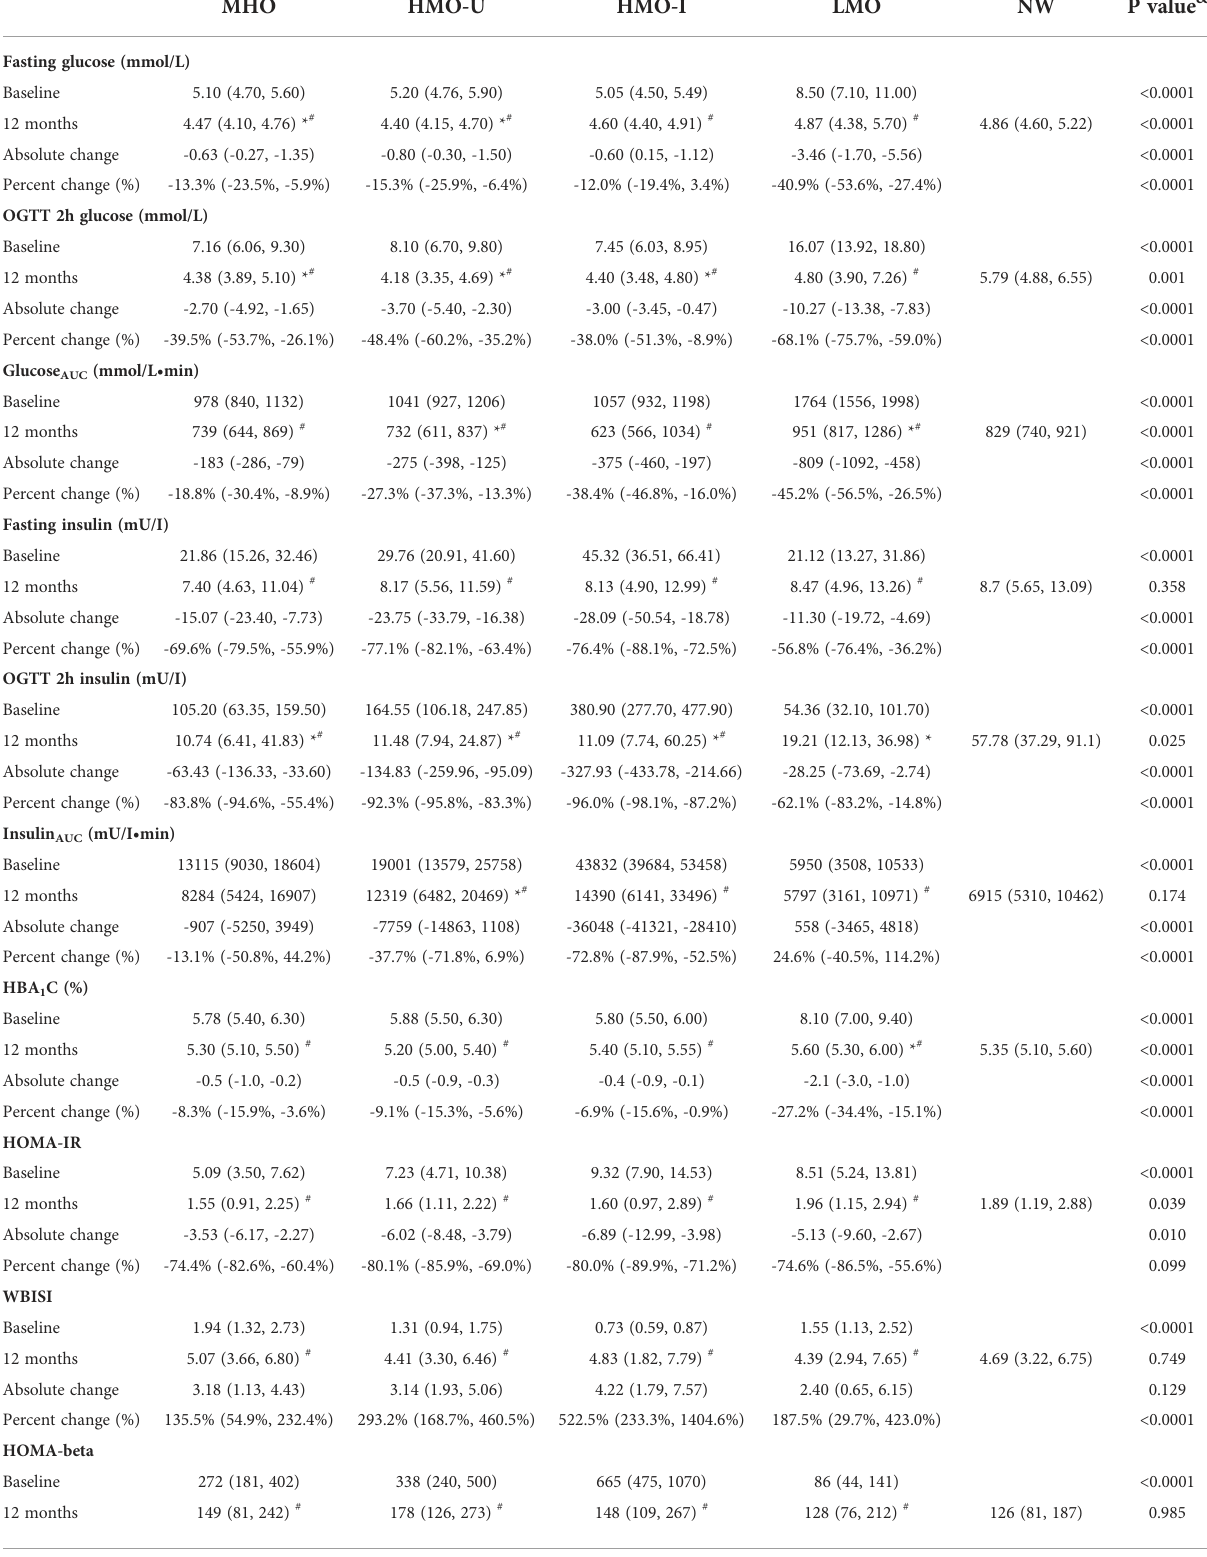
TABLE 2 The glucometabolism of the four AIM subgroups of obesity and normal weight controls at baseline and 12-month post-surgery. MHO HMO-U HMO-I LMO NW P value &